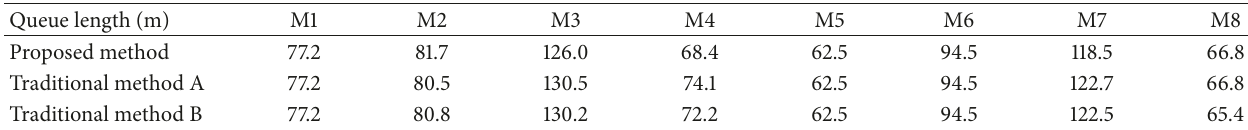
Table 4: Largest queue length.